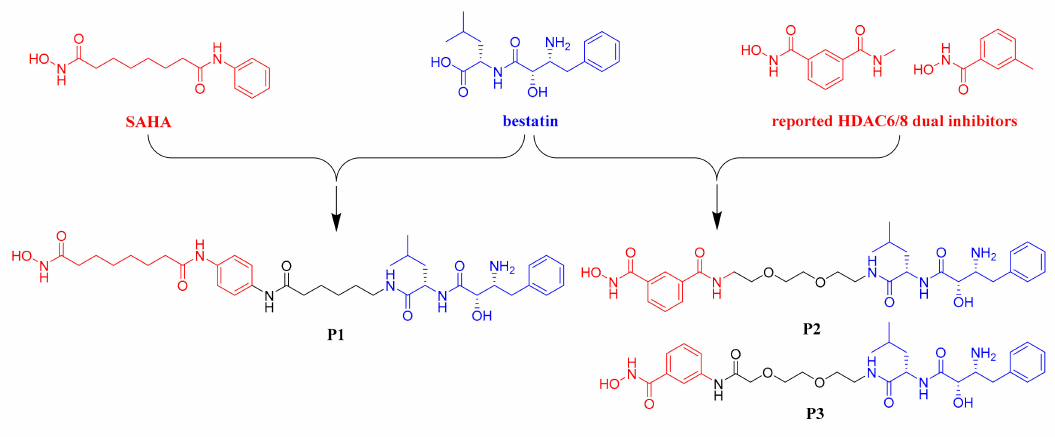
Figure 3. Design of bestatin-based hydroxamic